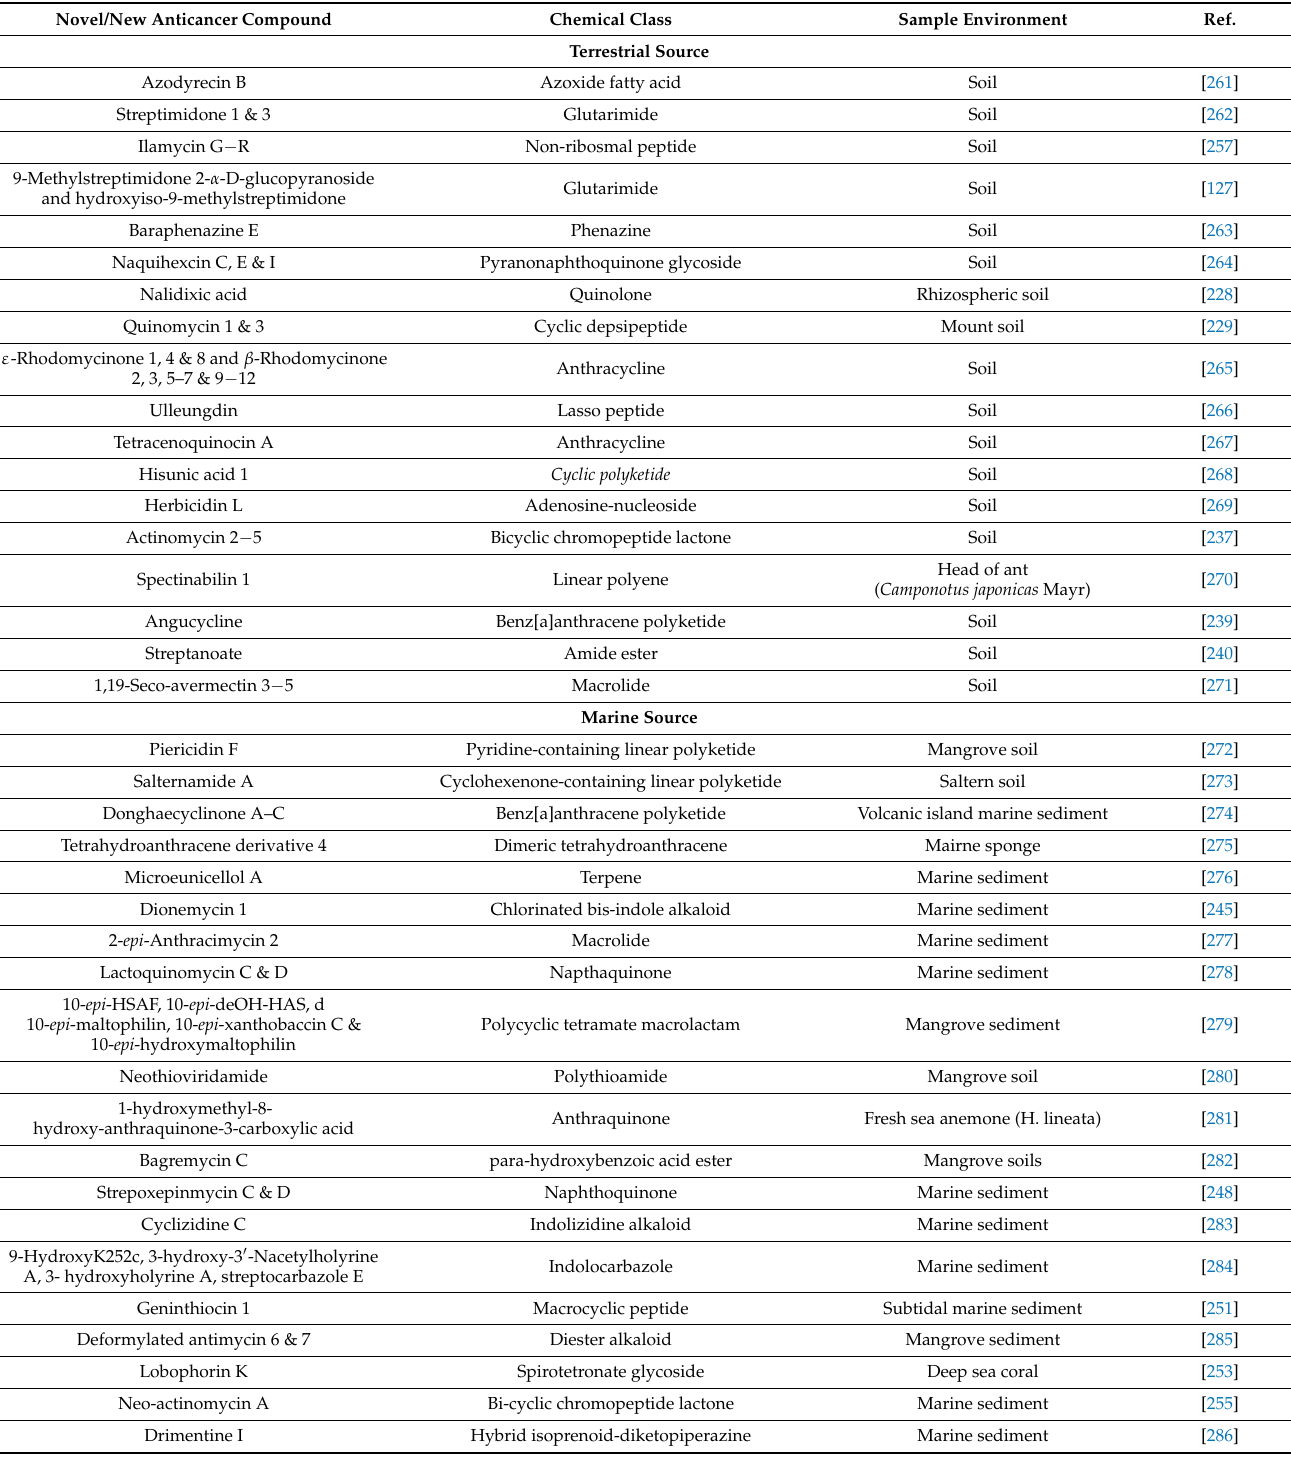
Table 10. Novel/new anticancer bioactive compounds isolated from Streptomyces spp. between 2015 and